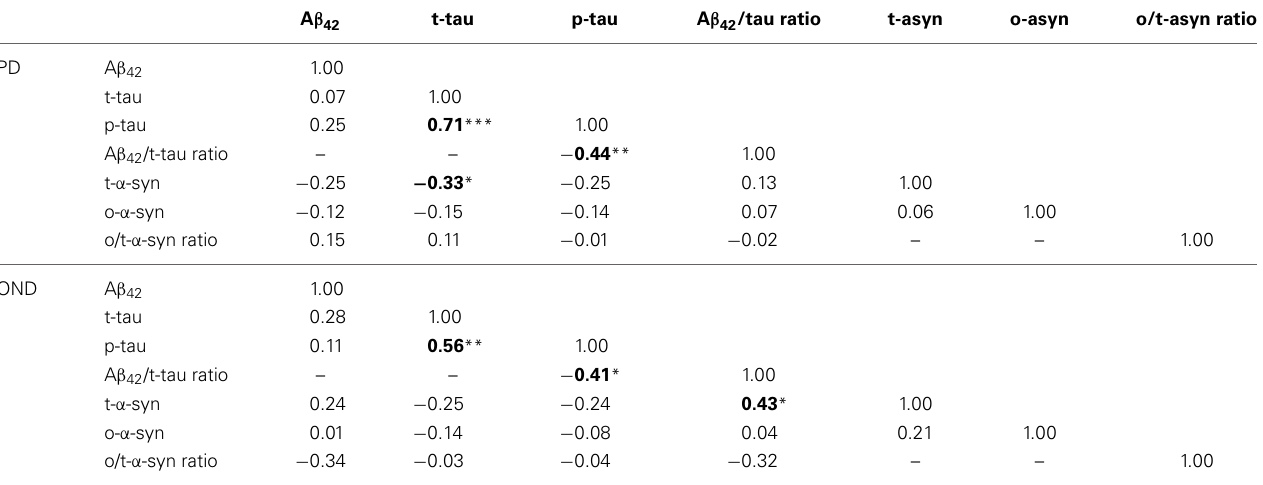
Table 3 | Spearman’s rank correlation matrix for CSF biomarkers in PD and OND